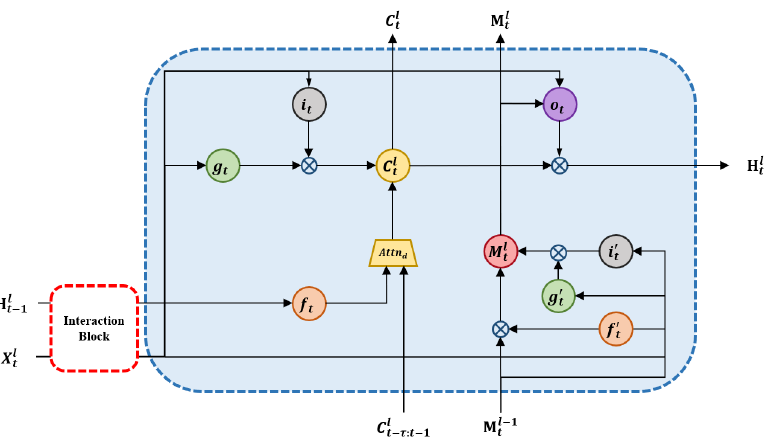
Figure 7. The inside structure of Interactional Dual Attention Long Short-term Memory (IDA- LSTM)